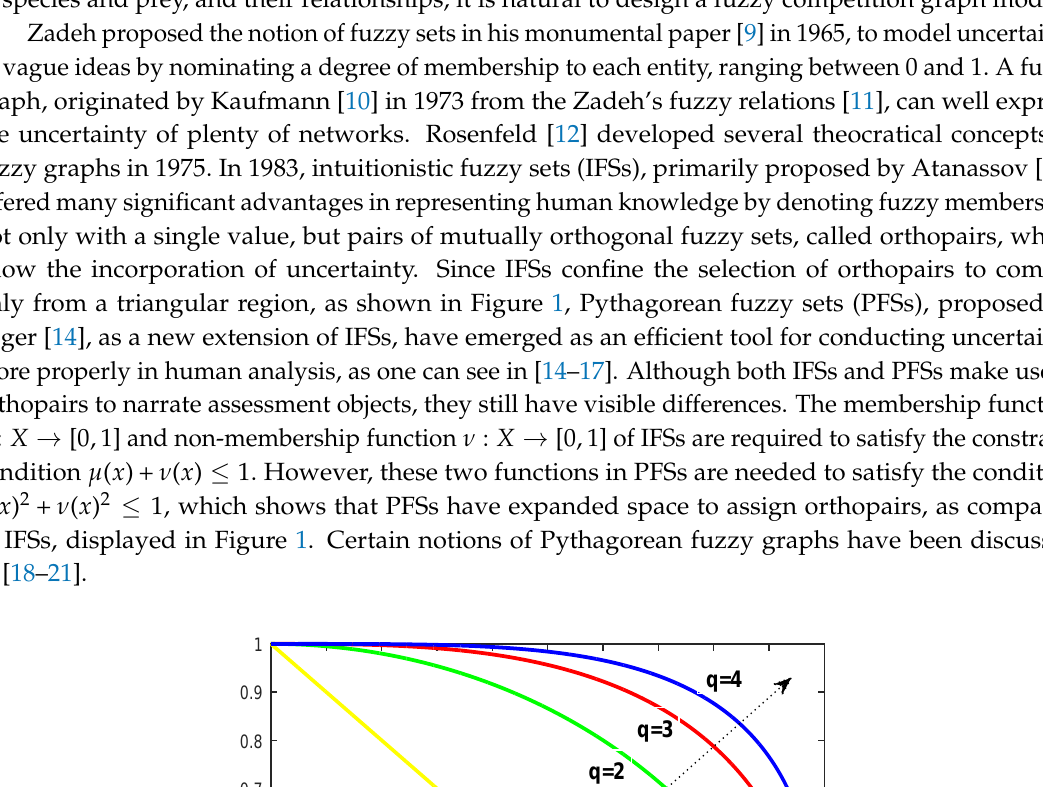
ν µ Figure 2.2: Geometric interpretation of height of q -ROFS 5